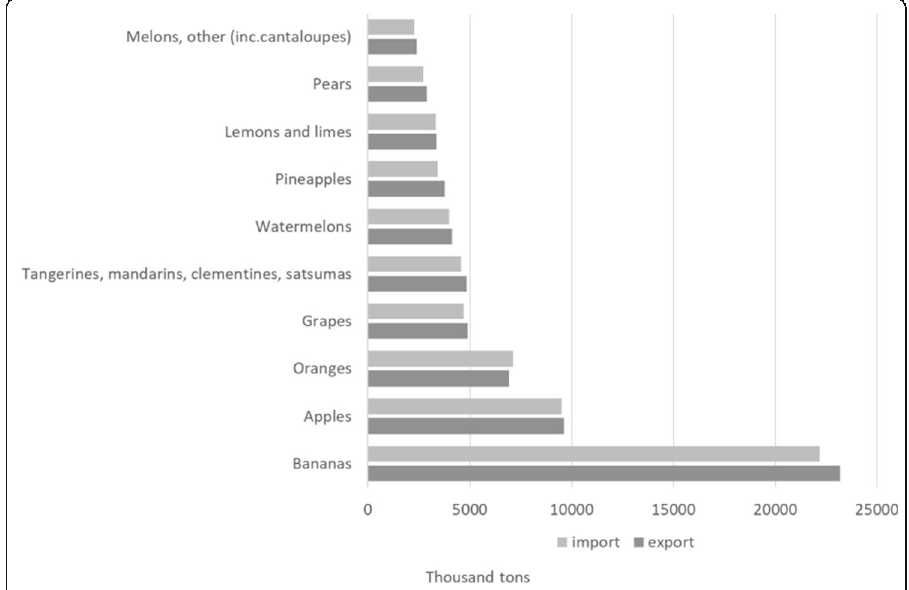
Fig. 3 Top 10 of the most traded fruits in 2017. Source: